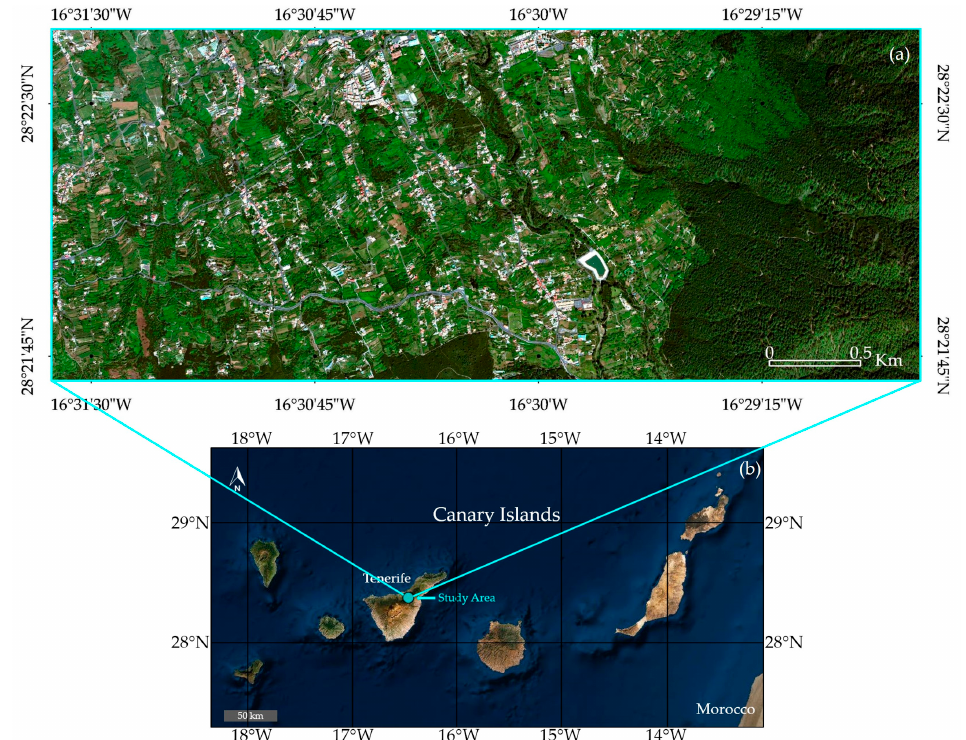
Figure 1. ( a ) WorldView-3 true colour image of 10th May 2015, demarcating the study area under the coordinates 28°22'43.16"N, 16°31'38.21"W (top-left corner) and 28°21'42.53"N, 16°28'42.38"W (bottom-right corner); ( b ) Archipelago of the Canary Islands, the light blue point shows the study area in Tenerife.